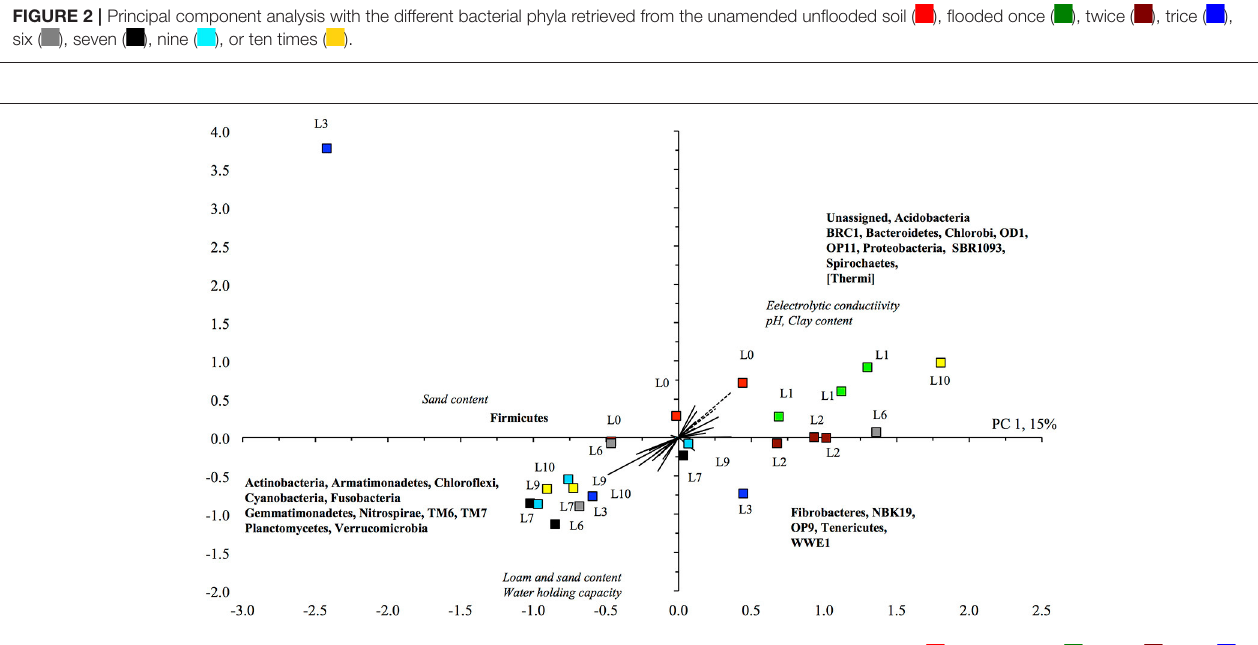
FIGURE 3 | Canonical component analysis with the different bacterial phyla retrieved from the unamended unflooded soil ( ), flooded once ( ), twice ( ), trice ( ), six ( ), seven ( ), nine ( ), or ten times ( ) at time 0 and the different soil characteristics.